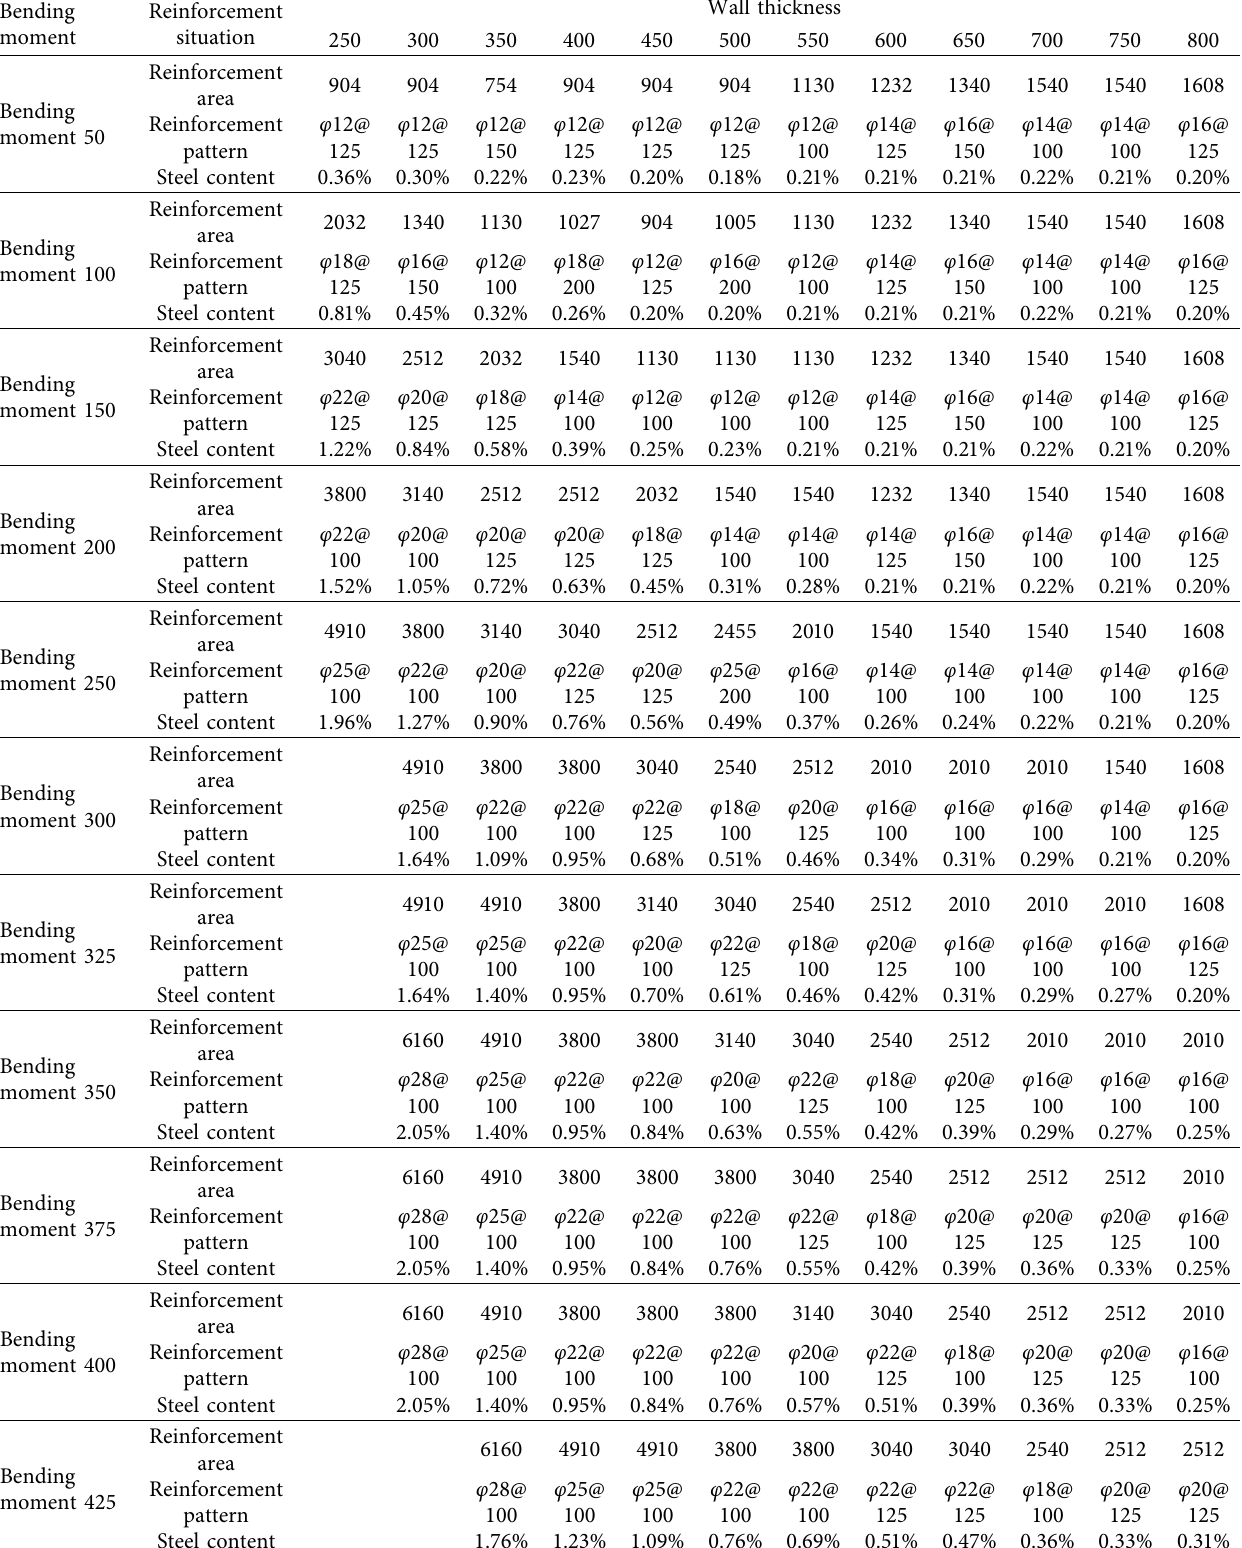
Table 5: Optimal wall thickness and optimal reinforcement situation at different bending